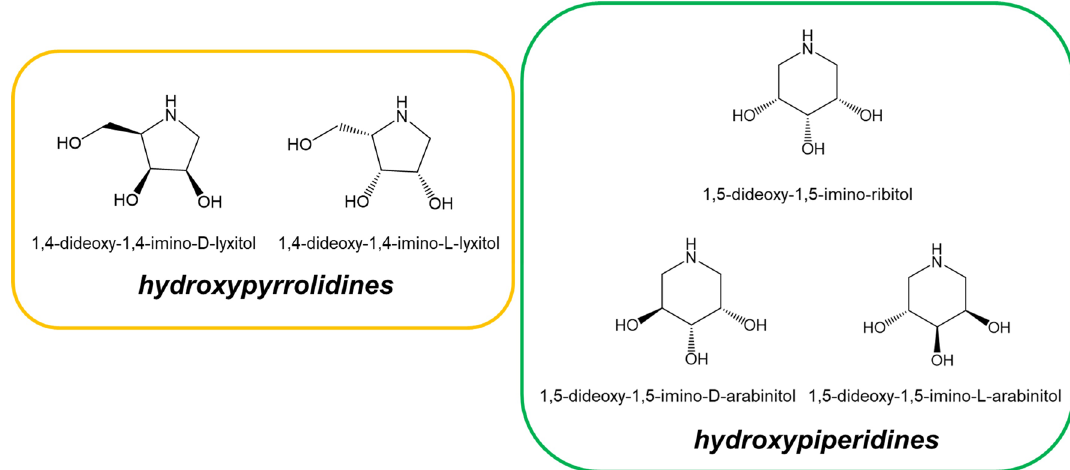
Figure 1. Structures of some hydroxypyrrolidine and hydroxypiperidine iminosugars.